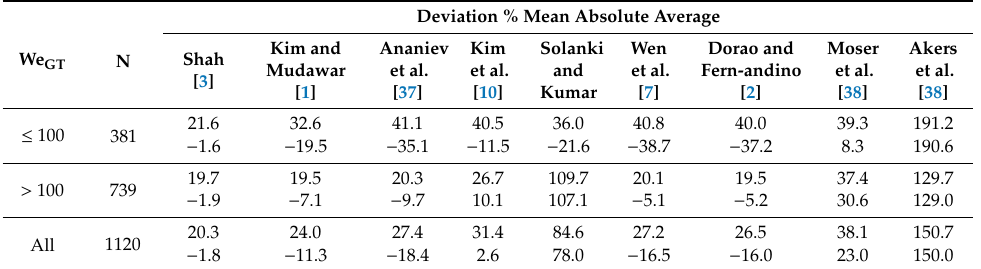
Table 4. E ff ect of Weber number on the accuracy of various correlations for data of non-circular channels other than flattened